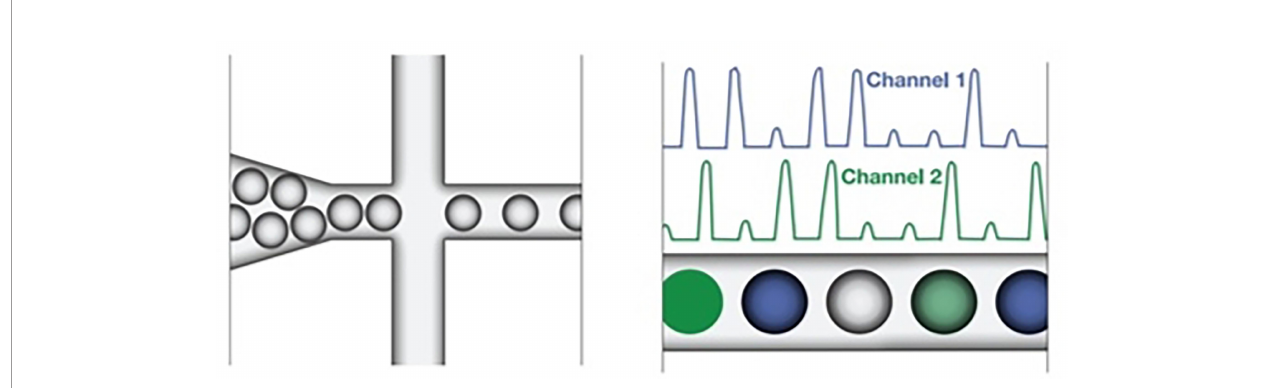
FIGURE 2 | The droplet reader reads spaced-out individual droplet fl uorescence in two channels in positive droplets with at least one copy of the target DNA molecule demonstrating increased fl uorescence compared to negative